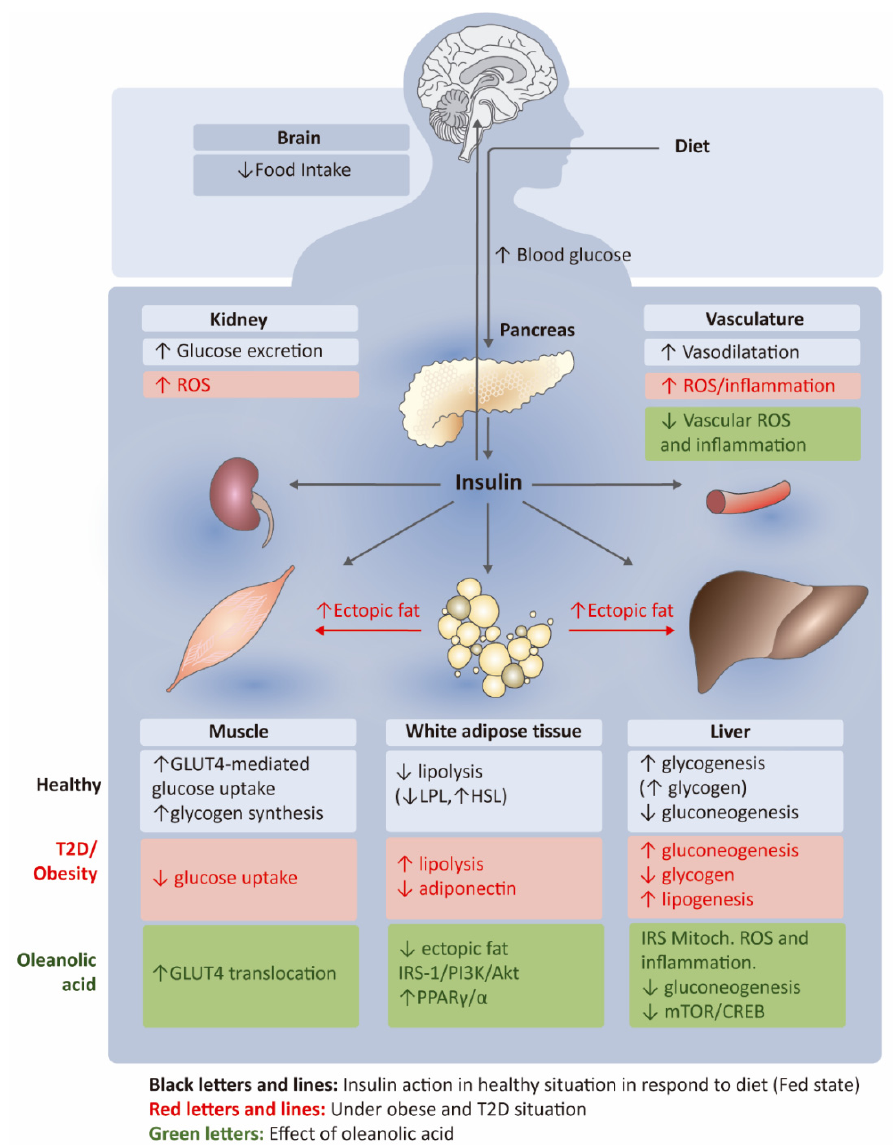
Figure 2. Key actions of insulin under healthy or obesity conditions in central and peripheral tissues in response to diet and the beneficial effects of oleanolic acid. In healthy individuals (black letters), insulin is released in response to diet, leading to glucose uptake in the muscle, hepatic production of glucose and glycogen, and attenuation of lipolysis in white adipose tissue and food intake reduction. These mechanisms are disrupted in obesity and type 2 diabetes (T2D) driving insulin resistance (red letters) with glucose uptake attenuation, increased lipolysis and hepatic production of glucose. In green letters are indicated the main actions and targets by which oleanolic acid is improving insulin sensitivity in obesity, thorough the promotion of glucose transporter translocation in muscle cells, reduction of ectopic fat accumulation, restoration of IRS-, PPAR- and mTOR-dependent pathways, ROS and inflammation in metabolically active tissues in the periphery. ROS, reactive oxygen species; GLUT4, glucose transporter type 4; LPL, lipoprotein lipase ; HSL, hormone-sensitive lipase; IRS-1, insulin receptor substrate 1; PI3K, phosphoinositide 3-kinases; Akt, protein kinase B; PPAR γ / α , peroxisome proliferator-activated receptor gamma/alpha; IRS-1, insulin receptor substrate 1; Mitoch., Mitochondrial; mTOR, mammalian target of rapamycin; CREB, cyclic adenosine monophosphate (cAMP)-response element binding protein; ↓ , decrease; ↑, increase .